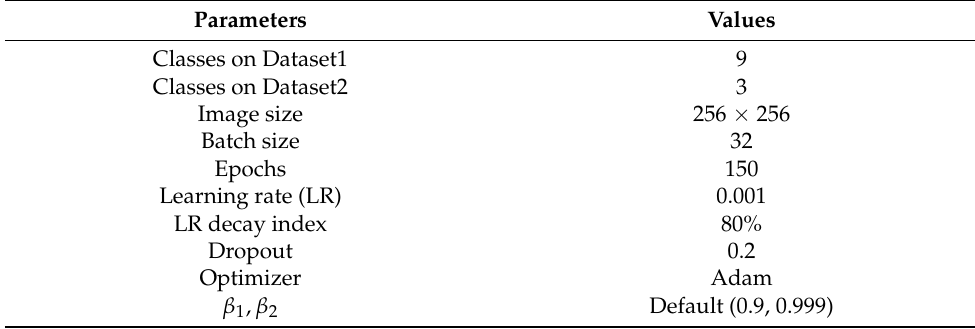
Table 2. Parameters and values adopted in the